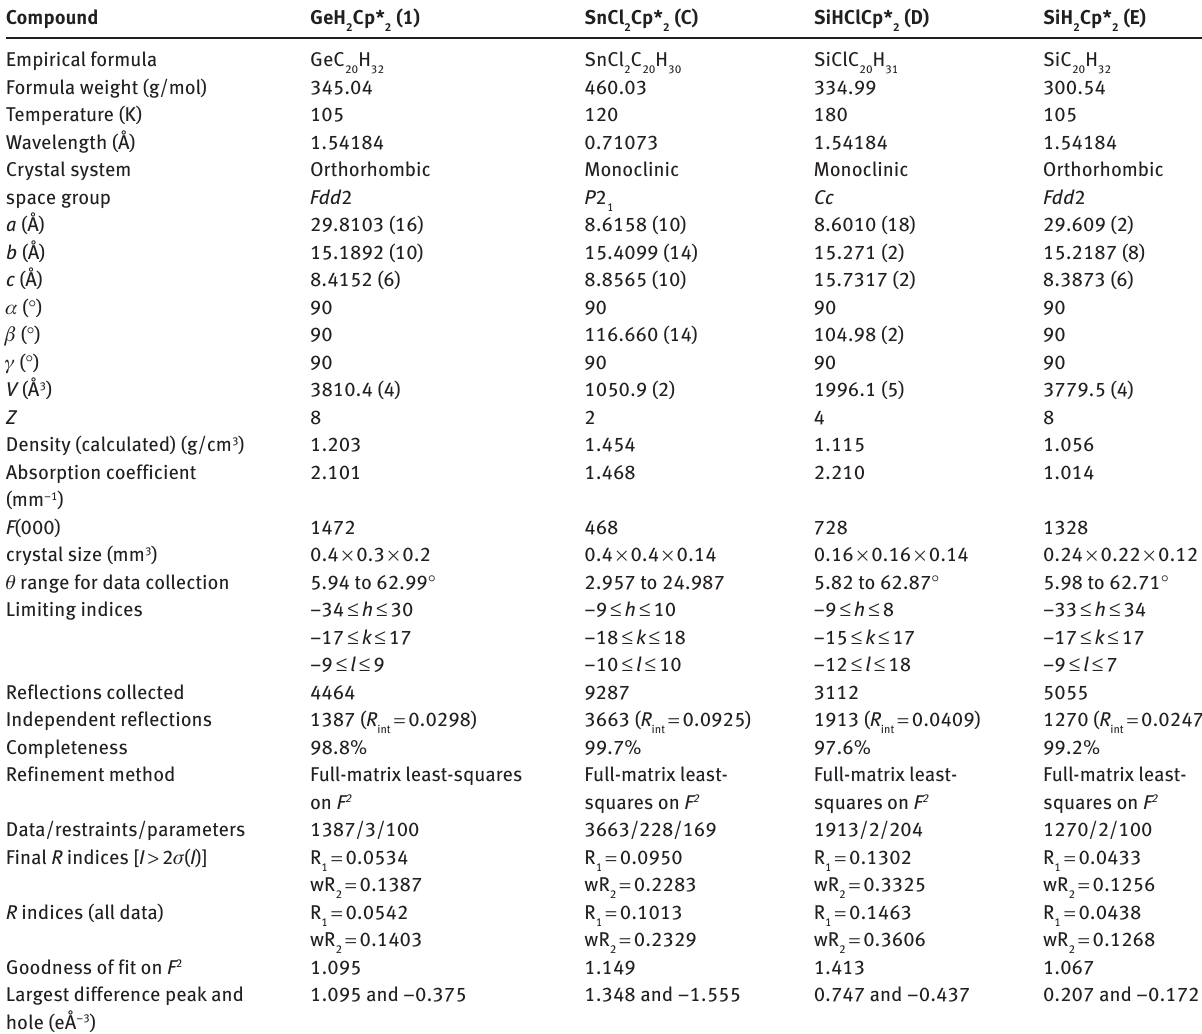
Table 2: Crystallographic data of compounds 1 , C , D and E .